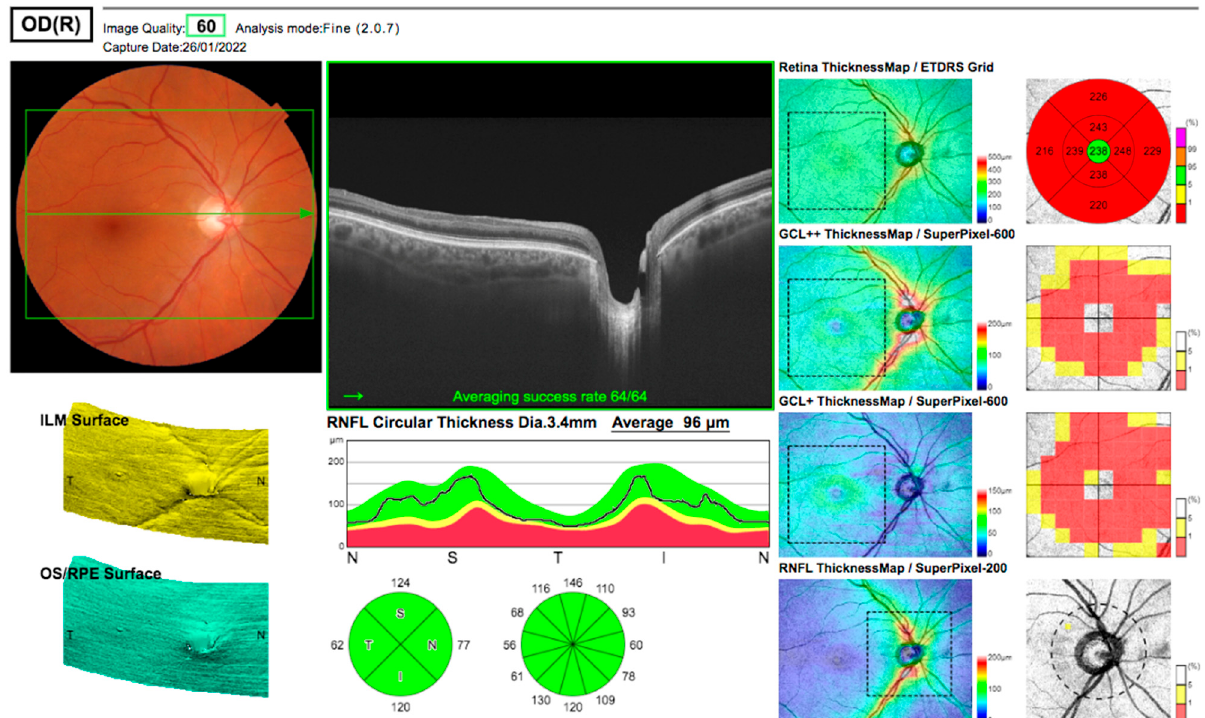
Figure 4. OCT imaging (26 January 2022) demonstrating persistent loss of the inner nuclear layer, with marked macular thinning but preserved circumpapillary retinal nerve fibre layer thickness.